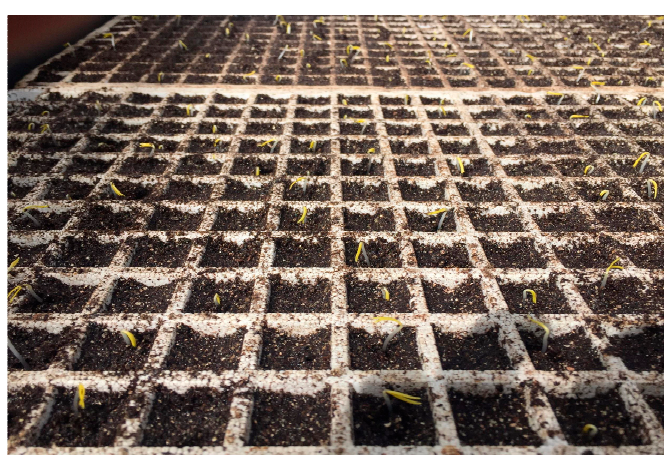
Figure 6. Flats just after floating with seedlings breaching the medium surface.